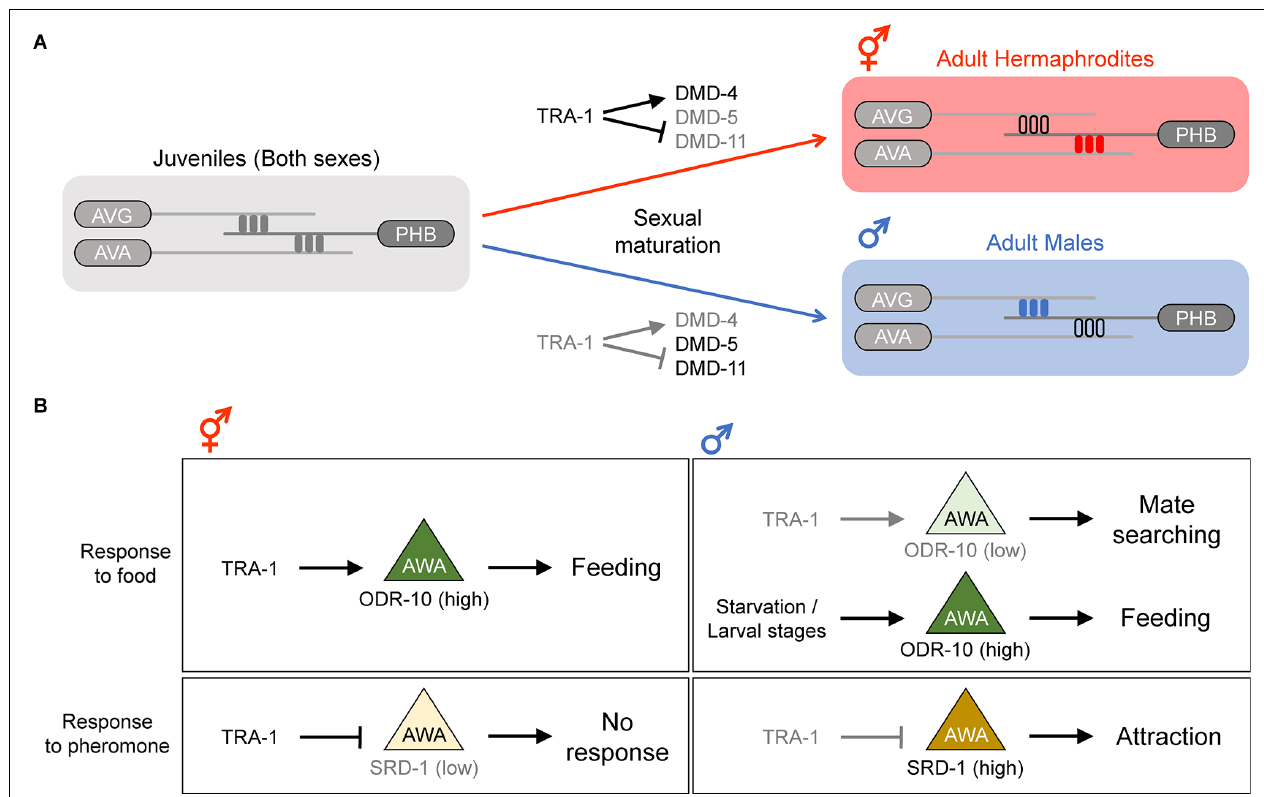
FIGURE 2 | Sex differences in synaptic connectivity and function of the sex-shared neurons. (A) Generation of sex-specific synaptic connections during the development. In larval stages, both sexes have identical synaptic connections. In the adult stage, sex-specific pruning events during sexual maturation result in sexually dimorphic connectivity; the PHB > AVG synapse is pruned in hermaphrodites, whereas the PHB > AVA synapse is pruned in males. Adapted from Barr et al. (2018). (B) Sexually dimorphic behavior influenced by differential gene expression in the AWA neuron. In hermaphrodites, ODR-10 expression is high in AWA, and thus feeding behavior is promoted. In males, ODR-10 expression depends on food availability; if food is plentiful, ODR-10 is downregulated, and thus mate searching is promoted. However, during starvation or the larval stages, ODR-10 is upregulated and feeding behavior is promoted. The expression ofSRD-1 in AWA also differs between the sexes, and this differential expression pattern contributes to the sex differences in response to the volatile sex pheromone; only males (with a high SRD-1 level) are attracted to the